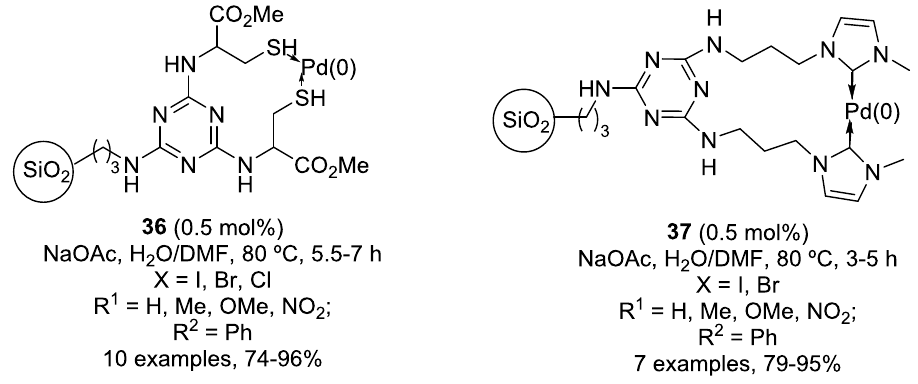
Figure 13. Silica bonded propylamine cyanuric palladium catalysts for the Sonogashira reaction. Conditions, substrate scope and yield range (Scheme 2).